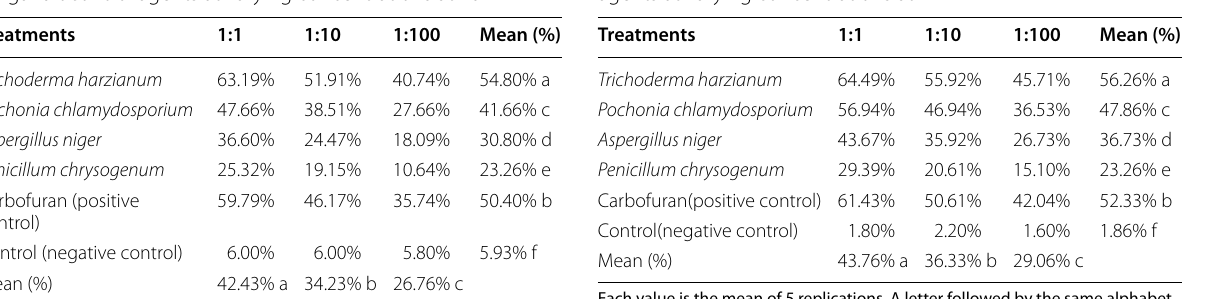
Table 4 Percentages of J2 mortality by various fungal biocontrol agents at varying concentrations at 24 h